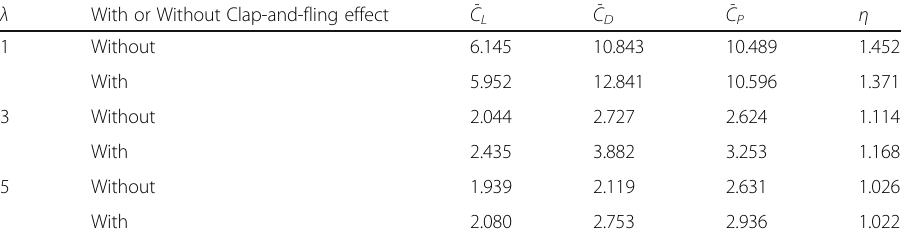
Table 5 Average aerodynamic coefficient and power coefficient under different aspect ratio